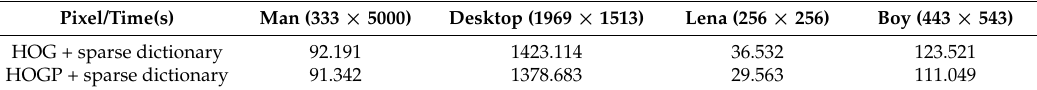
Table 1. Runtime